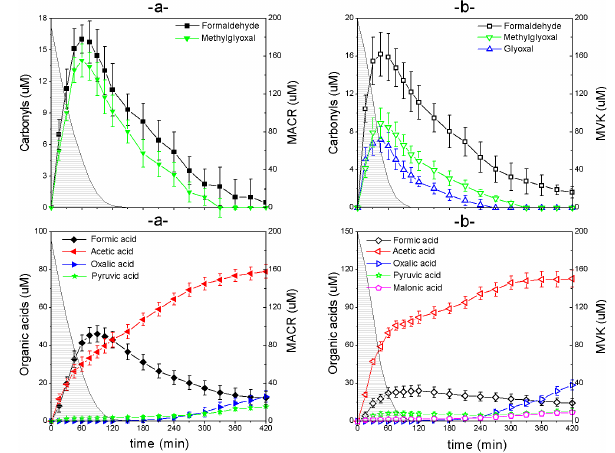
Fig. 2. Temporal concentration profiles of reactants and products in the aqueous OH-oxidation of (a) MACR, and (b) MVK (283K, pH =